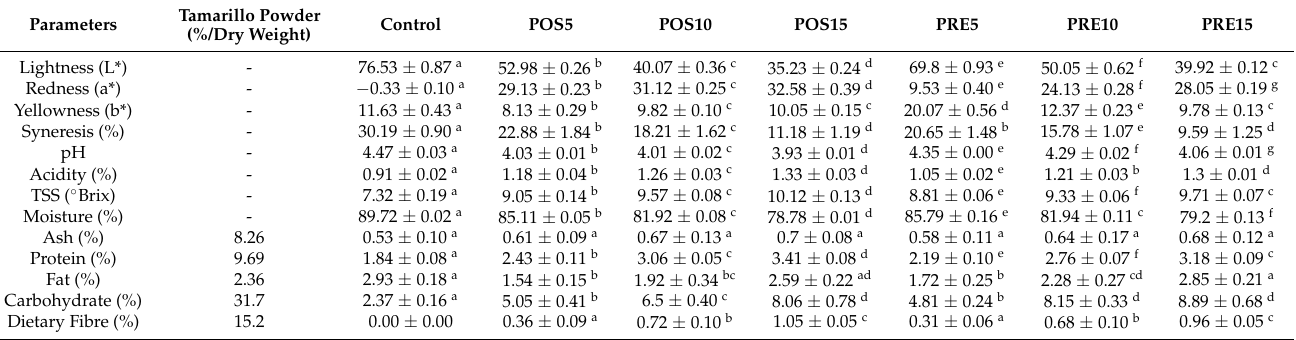
Table 1. Physical properties and proximate compositions of yoghurt samples and tamarillo powder.